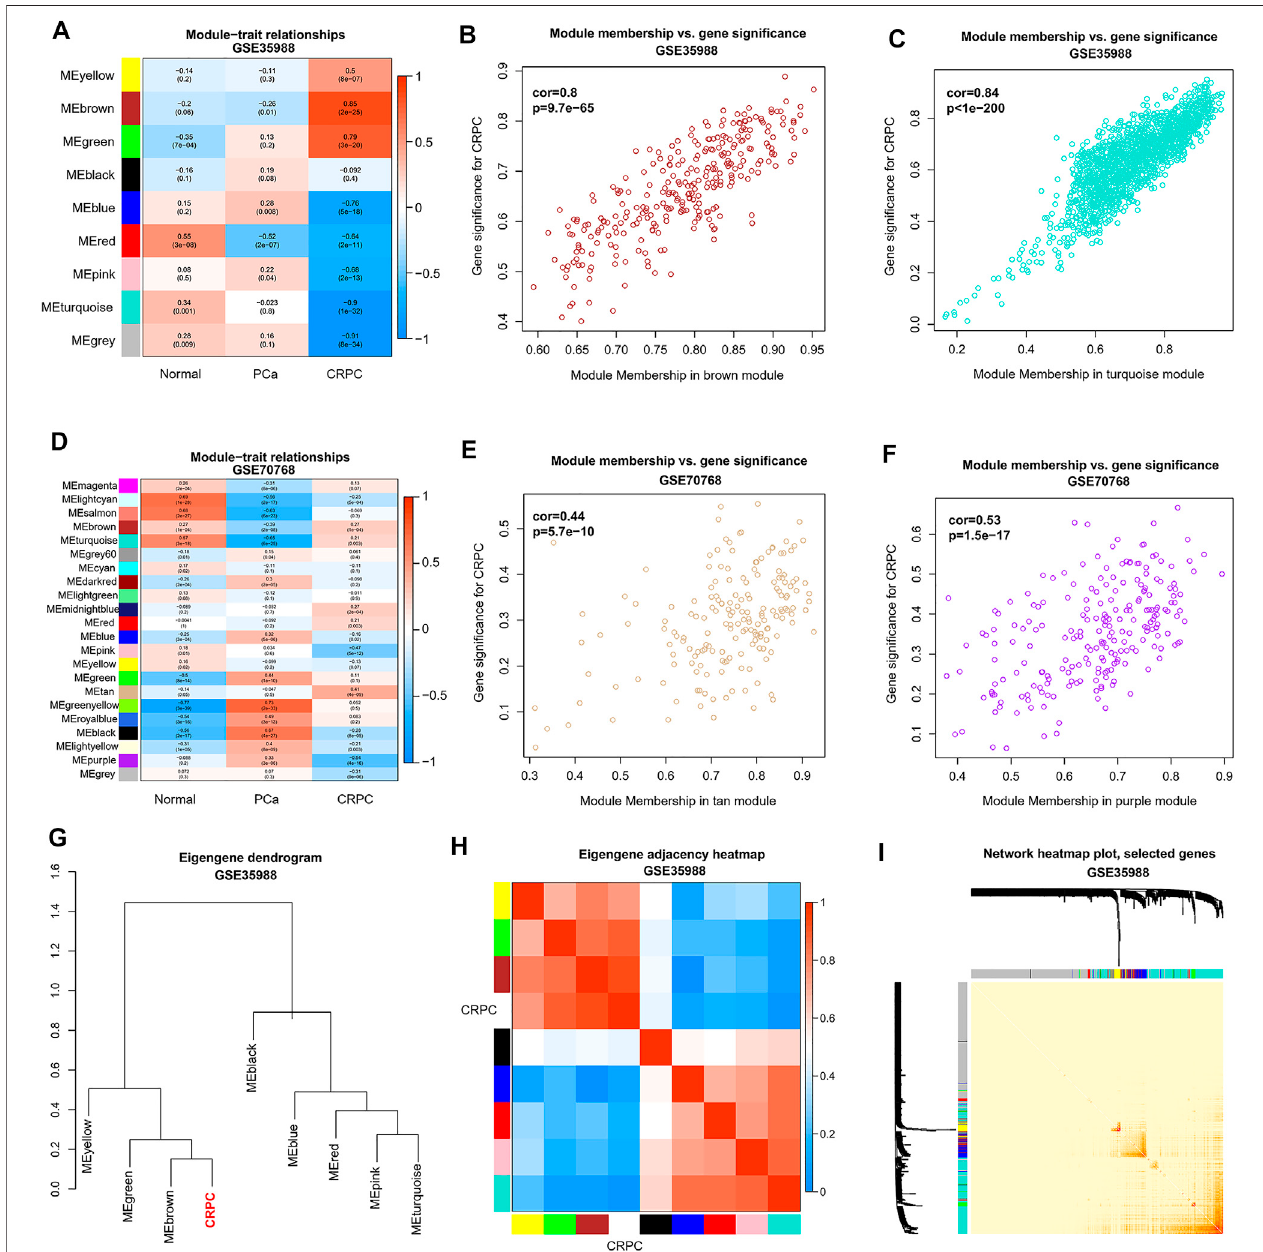
FIGURE 5 | Identi fi cation of CRPC-related modules and genes by WGCNA. (A,D) Heatmap of correlation between modules and sample types. (B,C,E,F) RelationshipbetweengenesandtraitsintheCRPC-relatedmodules. (G,H) Correlation betweenCRPCanddifferentmodulesindendrogram andheatmap. (I) Heatmap of a weighted network using 500 randomly selected